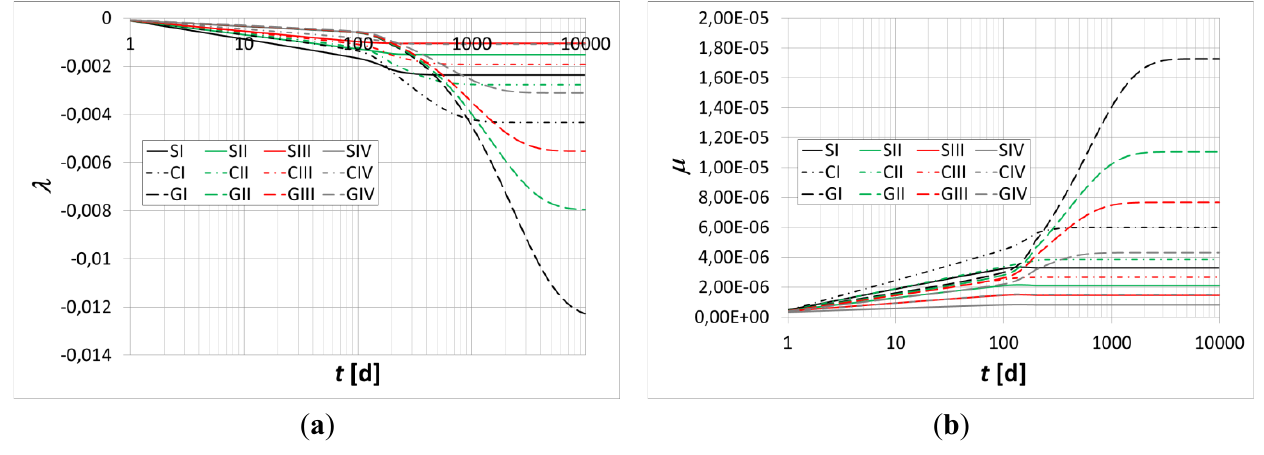
Figure 4. ( a ) Axial strain vs. time; ( b ) Curvature vs. time.